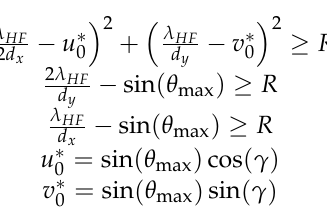
( b ) Figure 5. RP in the case of an antenna array with 8 × 8 isotropic elements arranged in a triangular lattice in the event of ( a )  = 30°, and ( b )  = 60°. The red circle represents the visible region, whereas the black circle highlights the circular sector cell. In order to find the most suitable triangular lattice grid — and hence, the  value — the angular average gain (  Gain ), namely, the mean value of the gain attained during the beam steering inside the all-circular sector, in the case of a planar array composed of 8 × 8 ele- ments, was evaluated as a function of the  value within the addressed bandwidth (24.25 – 29.5 GHz), and by considering the beam scan within the circular sector cell, as shown in Error! Reference source not found. . An element pattern shape equal to E (  ,  ) = cos(  ) ,